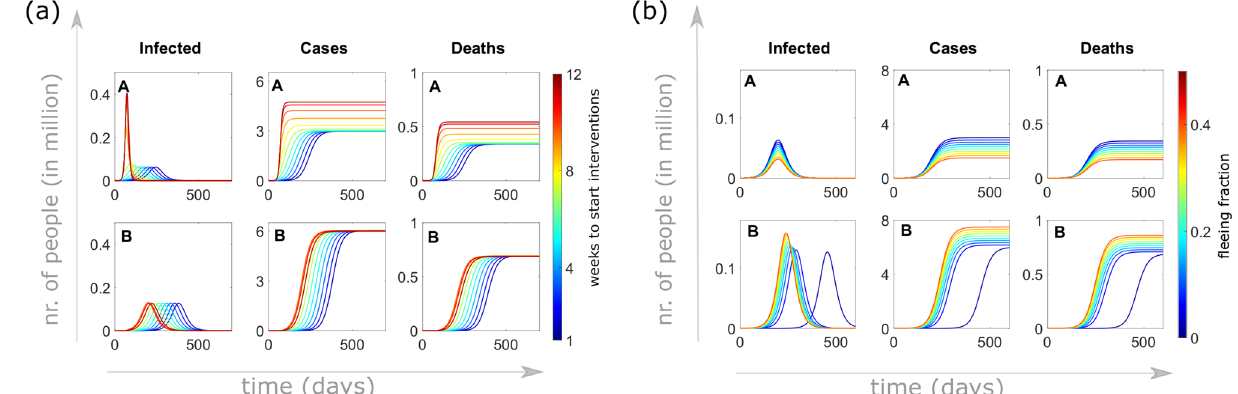
Figure 2. Detected infected cases and deaths depending on ( a ) the lockdown time T and ( b ) the fleeing fraction of exposed/undetected individuals at the time of the lockdown. An initial outbreak starts off with 20 cases and two deaths in region A (population 25 million), where lockdown is established at time T , immediately followed by lockdown-induced migration of a fraction of the unconstrained population from region A to the disease- free region B (population 50 million). ( a ) The lockdown time T varies from one to twelve weeks after the initial reporting, while the fleeing fraction is fixed to 1% of the unconstrained population in region A; ( b ) 0.01% to 50% of the unconstrained population moves from region A to region B at the fixed time T = 21 days after the initial reporting. At the time of lockdown, control measures are applied in both regions in order to restrict contacts by 60% and reduce transmission.